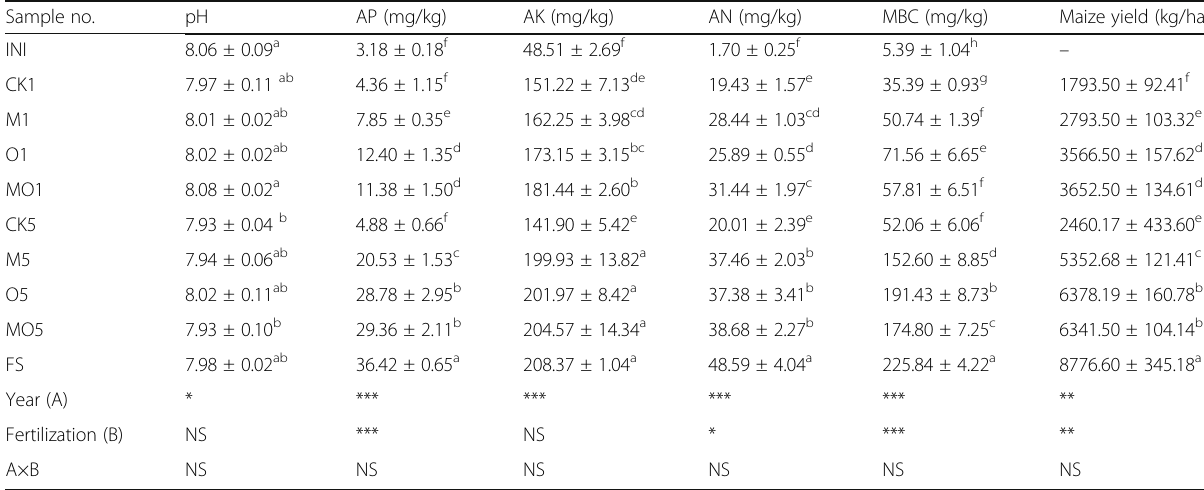
Table 1 Soil properties and maize yields at each experimental site Sample